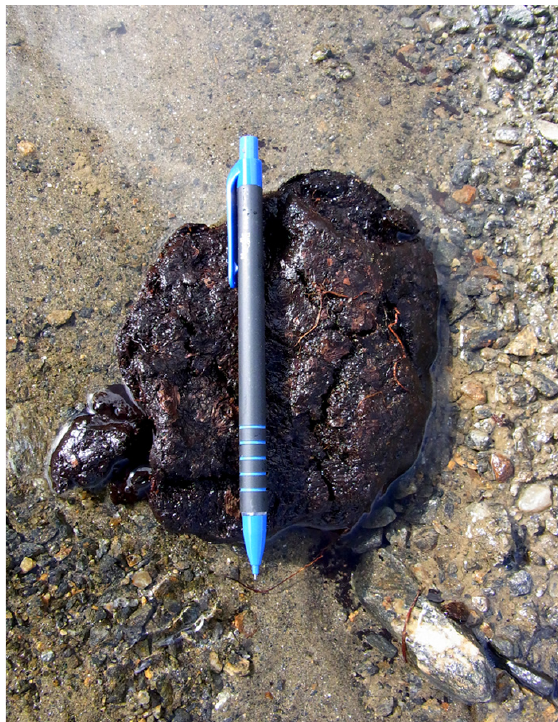
Figure 31: Tärnaglaciären (6). Strongly compressed peat, outwashed by a meltwater stream. 3890 cal. yr BP (Beta-268552).